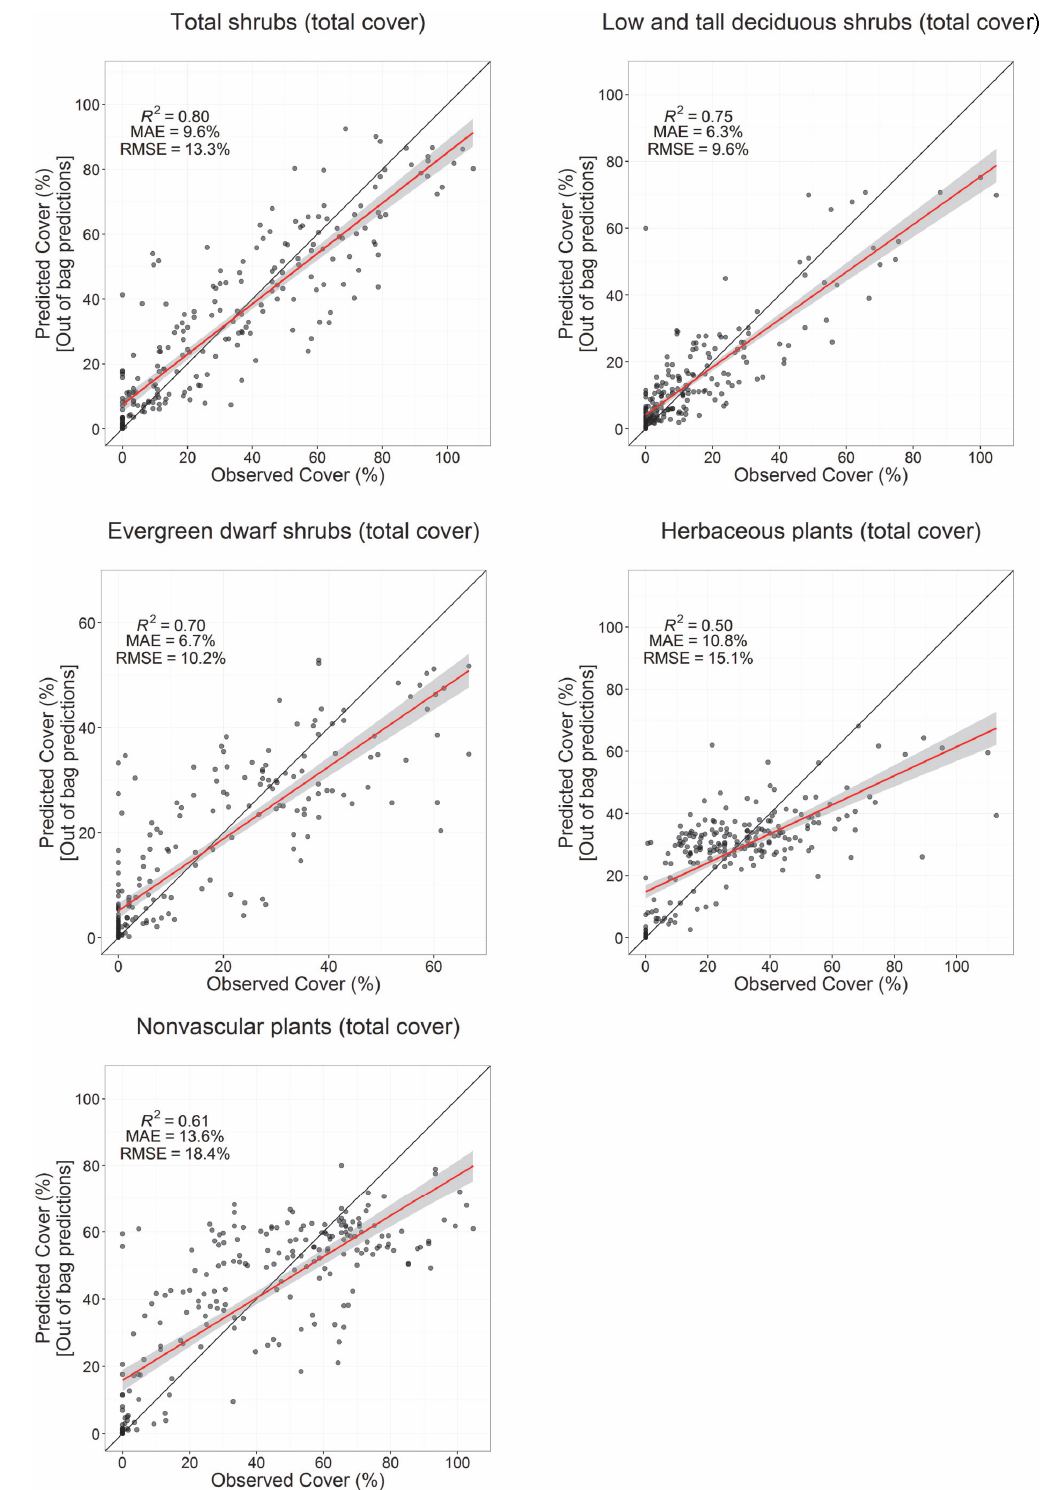
Figure 11. Scatterplots comparing observed and predicted cover values from training and validation plots for selected PFTs using the full set of 78 predictors. Predicted values for training data are “out-of-bag” predictions. The red lines are linear fits with 95% confidence intervals